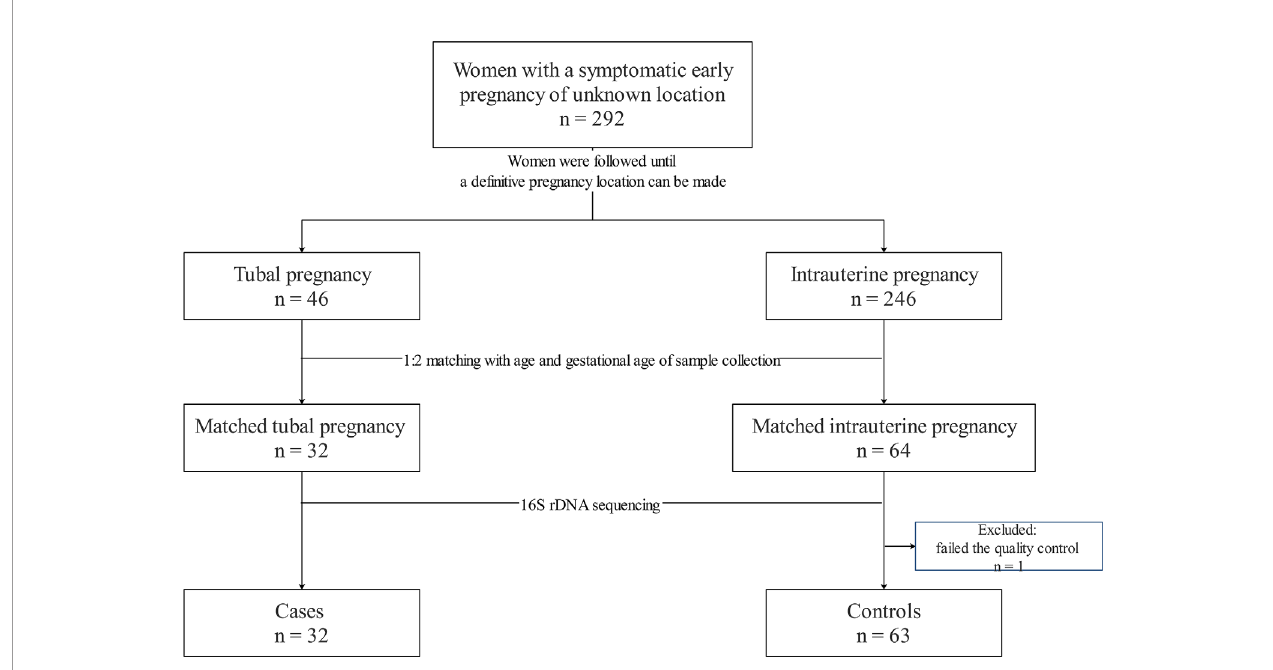
FIGURE 1 | Flowchart of the study.